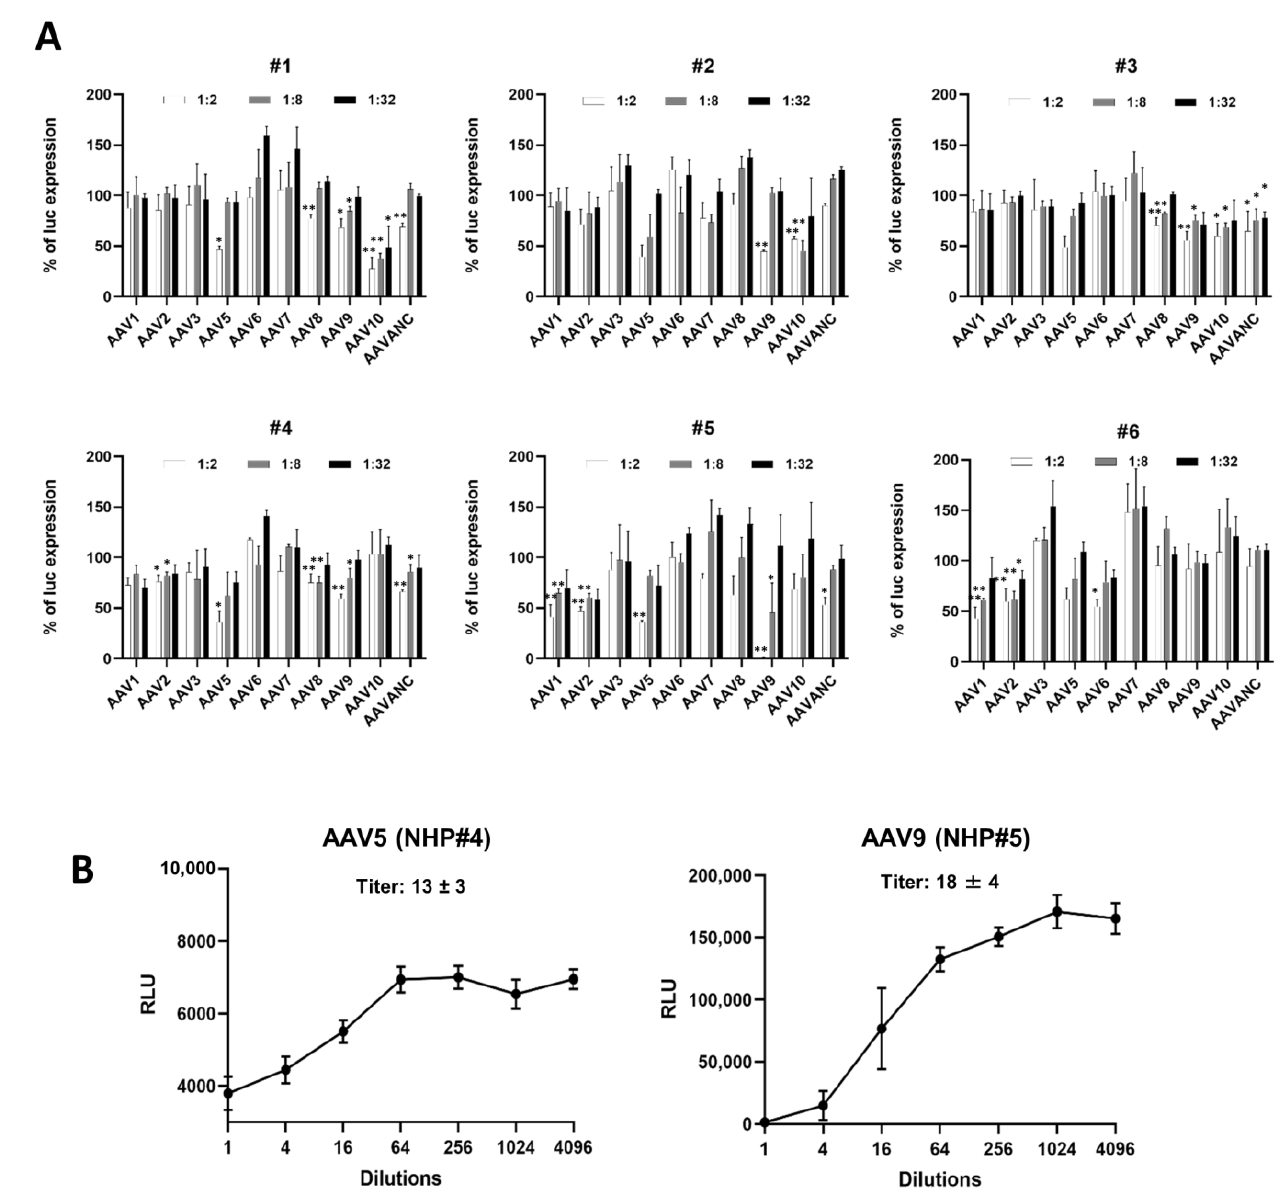
Figure 4. Anti-AAV NAB assay for non-human primate (NHP) samples. ( A ) Screening for the presence of NABs against 10 AAV serotypes in NHP serum ( n = 6). Samples were screened as described for human samples in Figure 2 at dilutions of 1:2, 1:8, and 1:32. Data are presented as the mean ± SD in triplicate. Statistically significant differences are indicated as p * < 0.05, p ** < 0.01 vs. uninhibited control for each AAV serotype. ( B ) NAB titers for AAV5 in NHP sample #4 and AAV9 in NHP sample #5 determined at dilutions ranging from 1:2 to 1:4096.